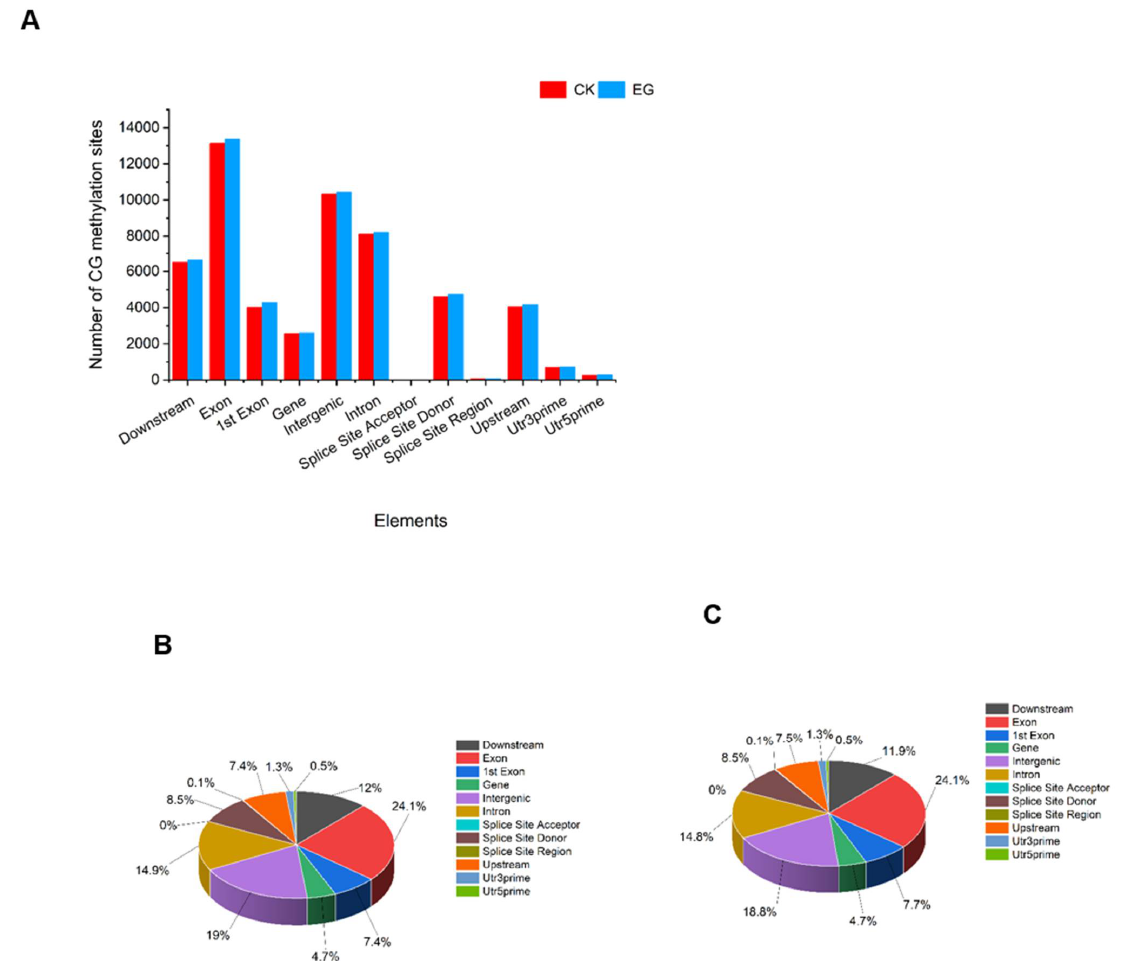
Figure 3. Distribution of methylation sites in different gene functional elements. ( A ) The distribution of mCG in elements count. ( B ) The proportion of the mCG distribution in the CK samples. ( C ) The proportion of the mCG distribution in the EG samples. CK is the control sample, and EG is the drought-stress sample.